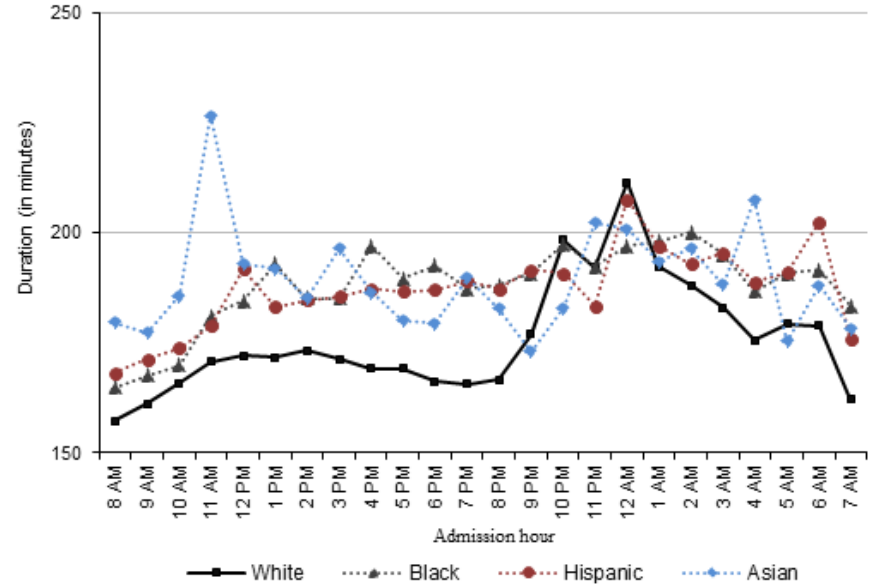
Figure 3. Mean duration of routine visits to the hospital emergency departments of non-teaching hospitals. Data include all hospital emergency department routine visits that are discharged for home or self care during 2008 in Arizona, Massachusetts, and Utah. Duration is measured in minutes as the difference between admission time and discharge time for each